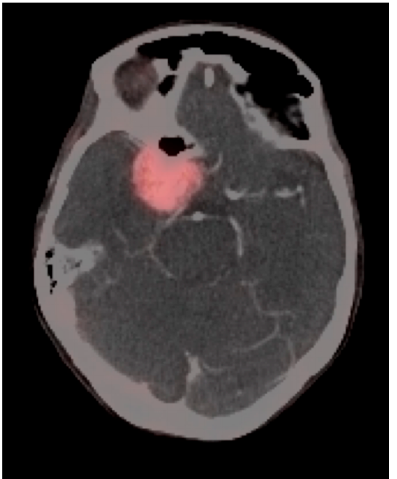
Figure 50. Meningioma on 68 Ga DOTATATE (NETSPOT ® ) PET ‐ CT. An axial NETSPOT ® PET ‐ CT performed with contrast ‐ enhanced CT demonstrates a strongly PET ‐ positive mass in the medial middle cranial fossa, corresponding to a contrast enhancing soft tissue mass with broad ‐ based abut ‐ ment of the sphenoid bone, typical in appearance for a meningioma.